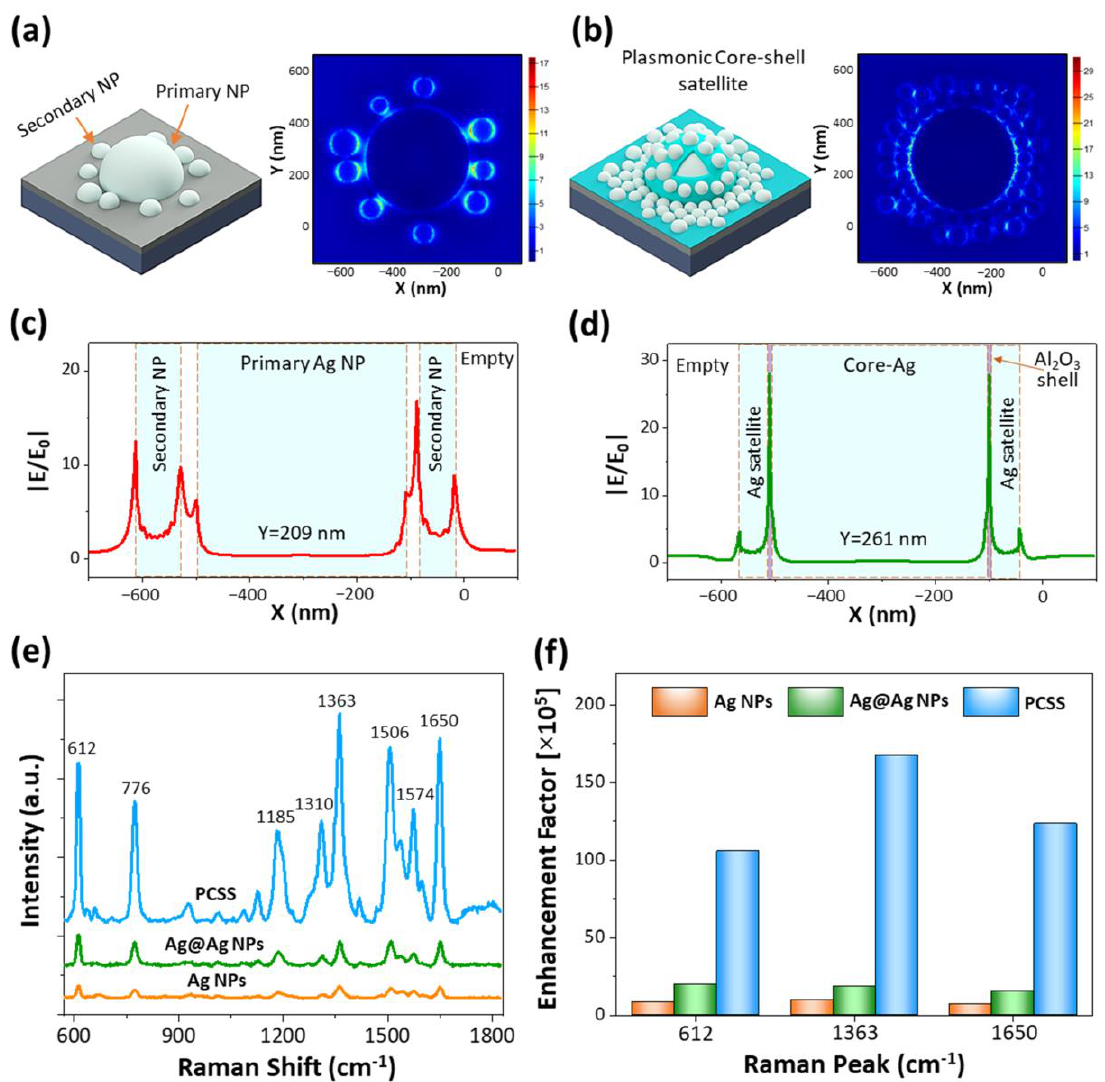
Figure 3. ( a , b ) FDTD simulation of Ag@Ag NPs and PCSS nanostructures. The EM-field enhancement was obtained by excitation at 532 nm. ( c , d ) Line profile of the EM-field intensity at particular regions of Ag@Ag NPs and PCSS nanostructures. ( e ) SERS spectra of R6G molecules (10 − 6 M) obtained from the Ag NPs template, Ag@Ag NPs, and PCSS nanostructures. ( f ) The plot of the SERS enhancement factor at Raman peaks 612, 1363, and 1650 cm − 1 .